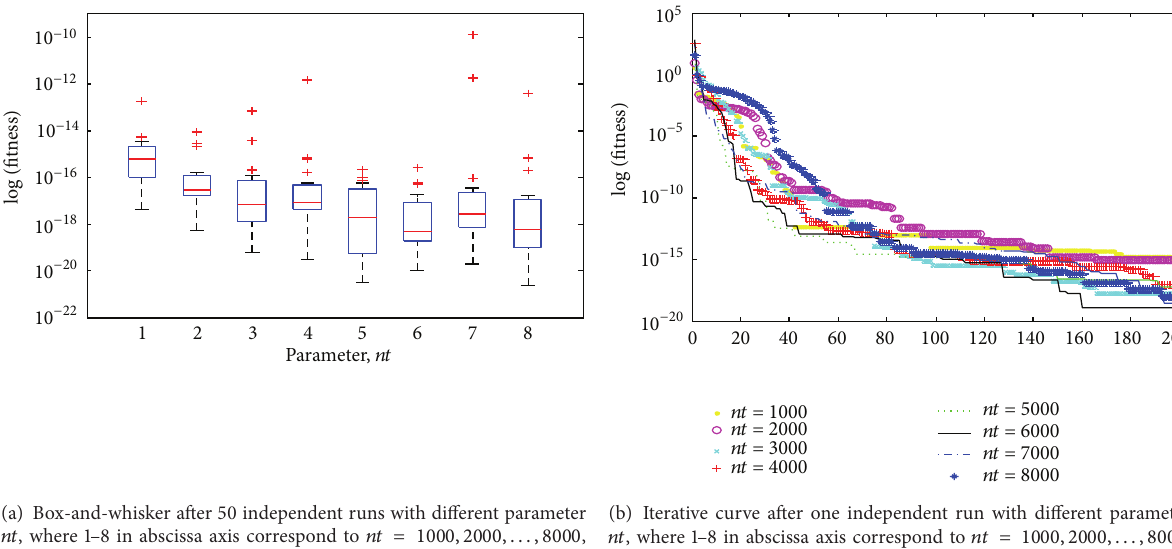
(b) Iterative curve after one independent run with different parameter 𝑛𝑡 , where 1–8 in abscissa axis correspond to 𝑛𝑡 = 1000,2000,...,8000 , respectively Figure 5: Box-and-whisker diagram and iterative curve about the impact of different parameter 𝑛𝑡 .